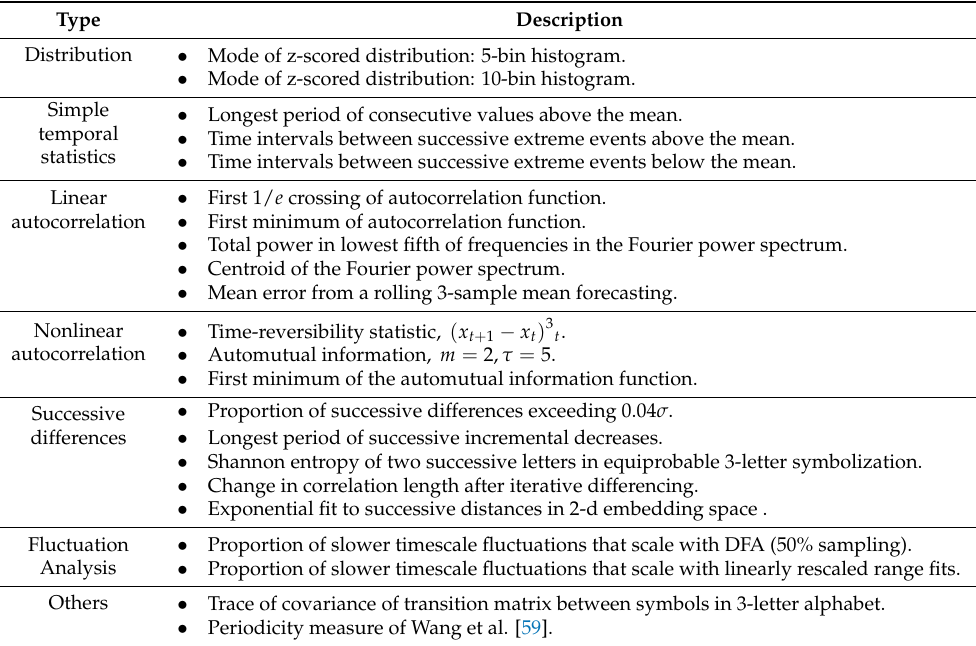
Table 2. Time-series features suggested by Lubba et al. [28] and included in CATCH22